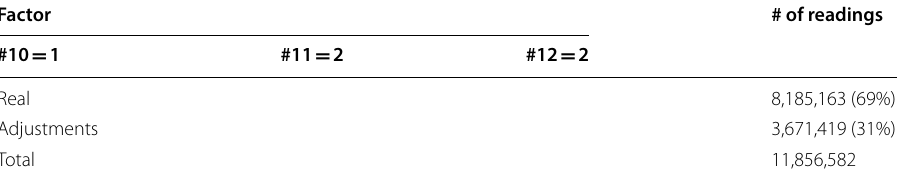
Table 6 Proportion of real measurements vs adjustments (with the 1-2-2 Factor)